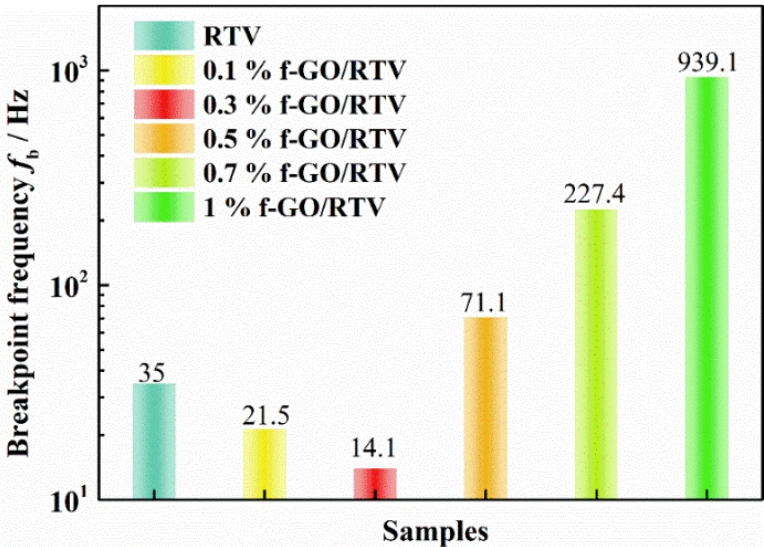
Figure 11. Variations in breakpoint frequency f b of RTV nanocomposite coatings with different filler content of f-GO nanosheets after NO 2 oxidation.